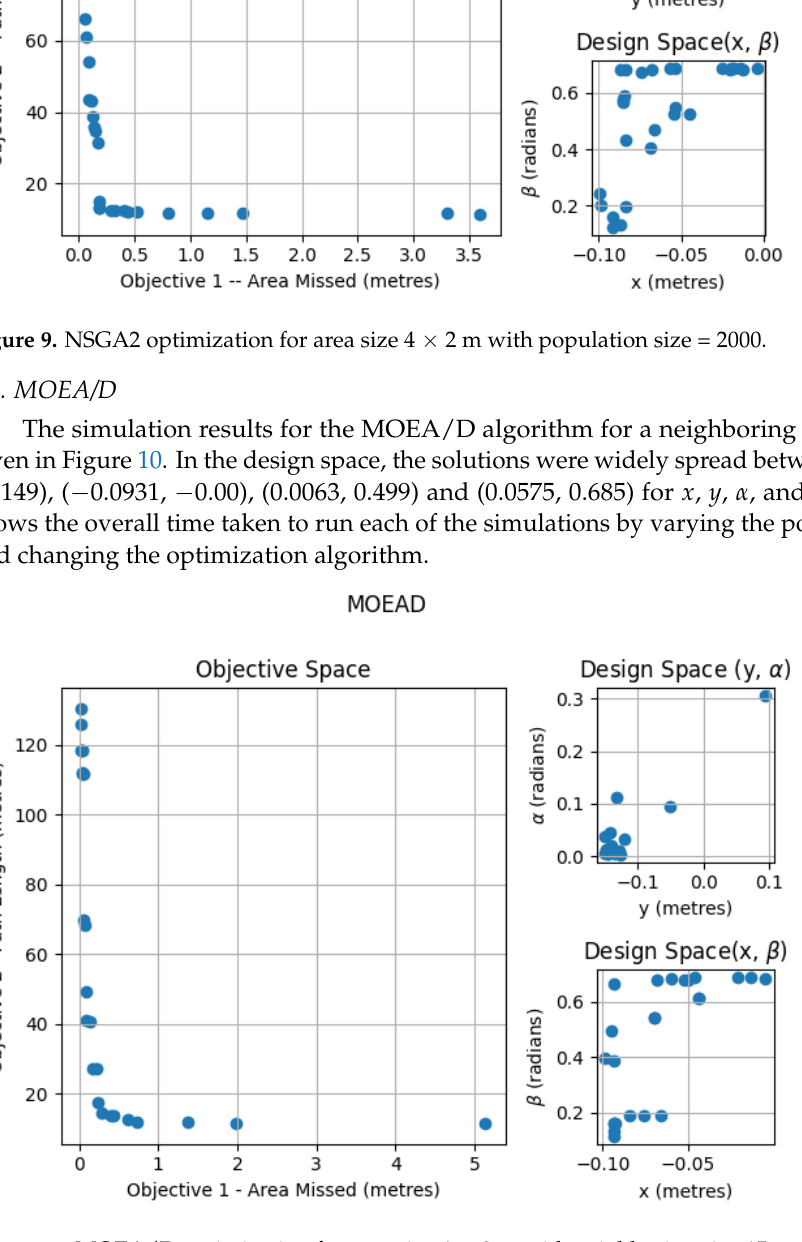
Figure 10. MOEA/D optimization for area size 4 × 2 m with neighboring size